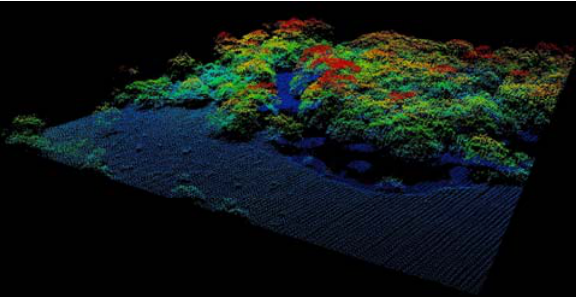
Table 3. The Pearson’s Chi-squared Test Results to